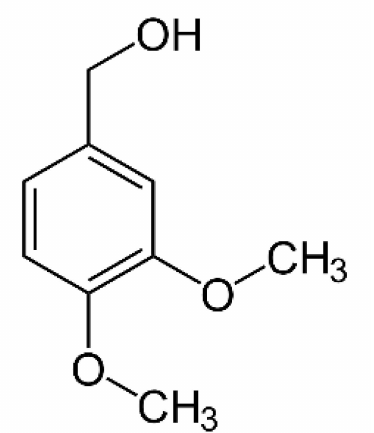
Figure 1. 3,4-dimethoxy benzyl alcohol (veratryl alcohol) molecular